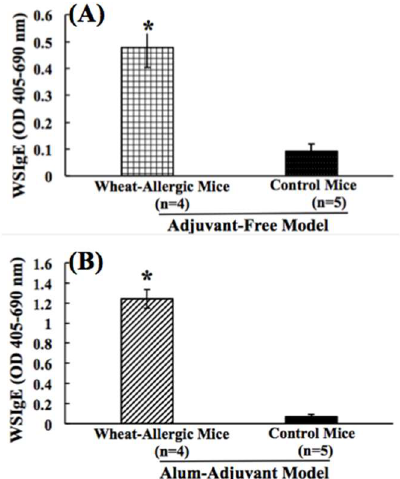
Figure 1. ( A–B ). Comparison of wheat protein-specific IgE antibody responses in the adjuvant-free (AF) vs. the alum-adjuvant (AA) mouse models of wheat allergenicity. ( A ) In the AF model, Balb/c mice were exposed to salt-soluble wheat protein (SSWP) once a week for 6 weeks via the transdermal route, as described in the methods. A group of control mice did not receive this exposure. Plasma collected after 6 weeks of exposure sensitization was used in the wheat-specific IgE (WSIgE) antibody analysis using an ELISA method described previously [32]. Figure shows the WSIgE levels in allergic mice vs. the control mice in the AF model. ( B ) In the AA model, Balb/c mice were injected with SSWP along with alum by the intraperitoneal route, as described in the methods. A group of control mice received alum only for the injection. Plasma collected after 6 weeks of sensitization was used in the WSIgE antibody analysis using an ELISA method described previously [32]. Figure shows WSIgE levels in allergic mice vs. the control mice in the AA model. * Student’s t test, p < 0.05.